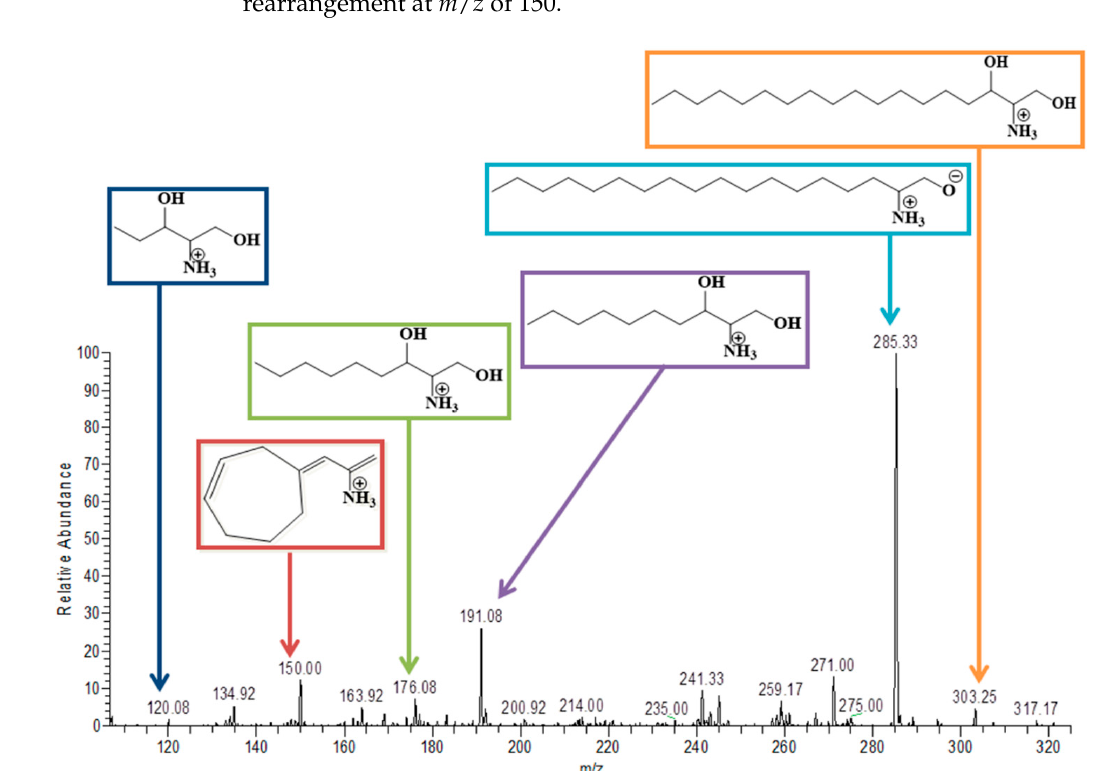
Figure 6. MS/MS spectrum of Sphinganine in positive ion mode.